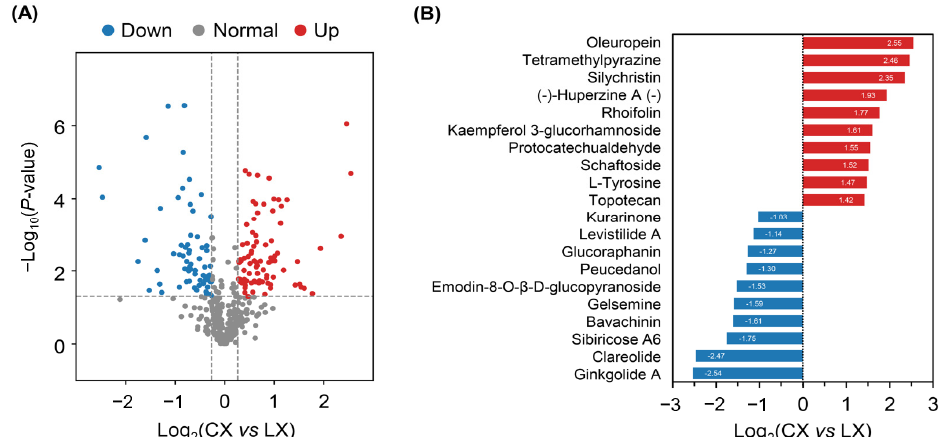
Figure 4. Identification of differentially abundant metabolites (DAMs). ( A ) Volcano plots of DAMs between CX and LX. ( B ) Top 20 most significant DAMs.